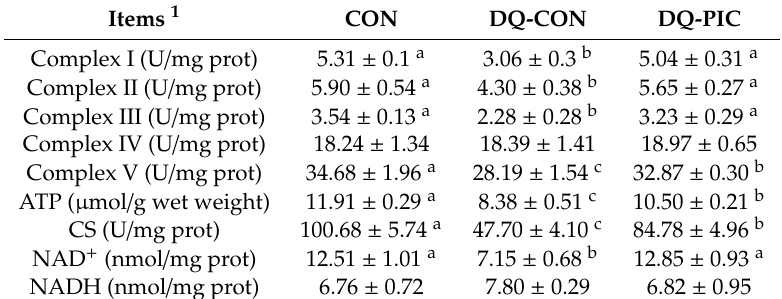
Table 7. E ff ects of piceatannol supplementation on activities of mitochondrial complex in the liver of diquat-induced